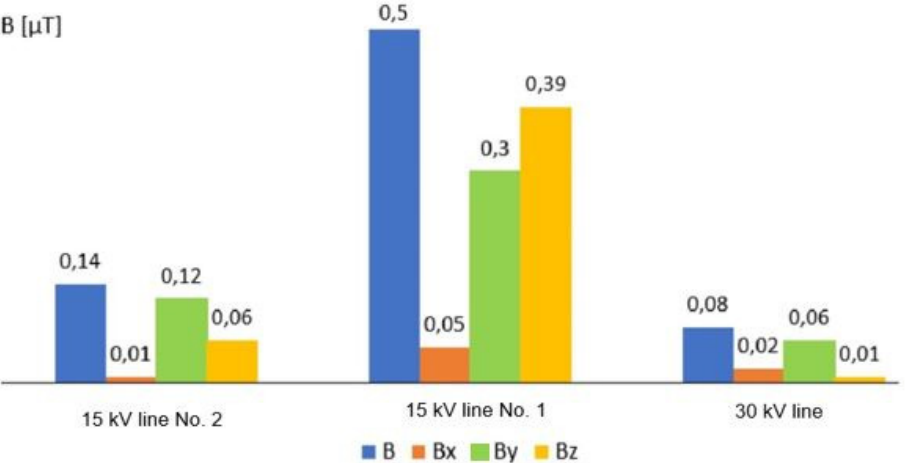
Figure 4. The value of magnetic field induction B and its components B x , B y , B z at the point of maximum cable sag in the power line supplying the container with telematics and security systems. Maximum magnetic field induction B under MV lines for the ELF range was recorded at measuring point No. 2.